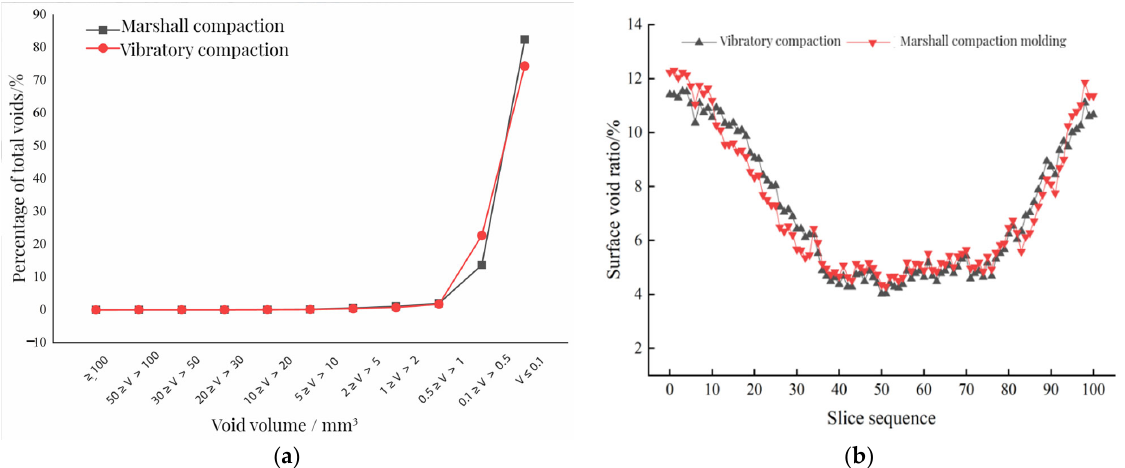
Figure 13. The void gradation and surface porosity of PCRM under di ff erent molding methods. ( a ) PCRM void gradation distribution. ( b ) Void distribution characteristics of di ff erent forming meth- ods.